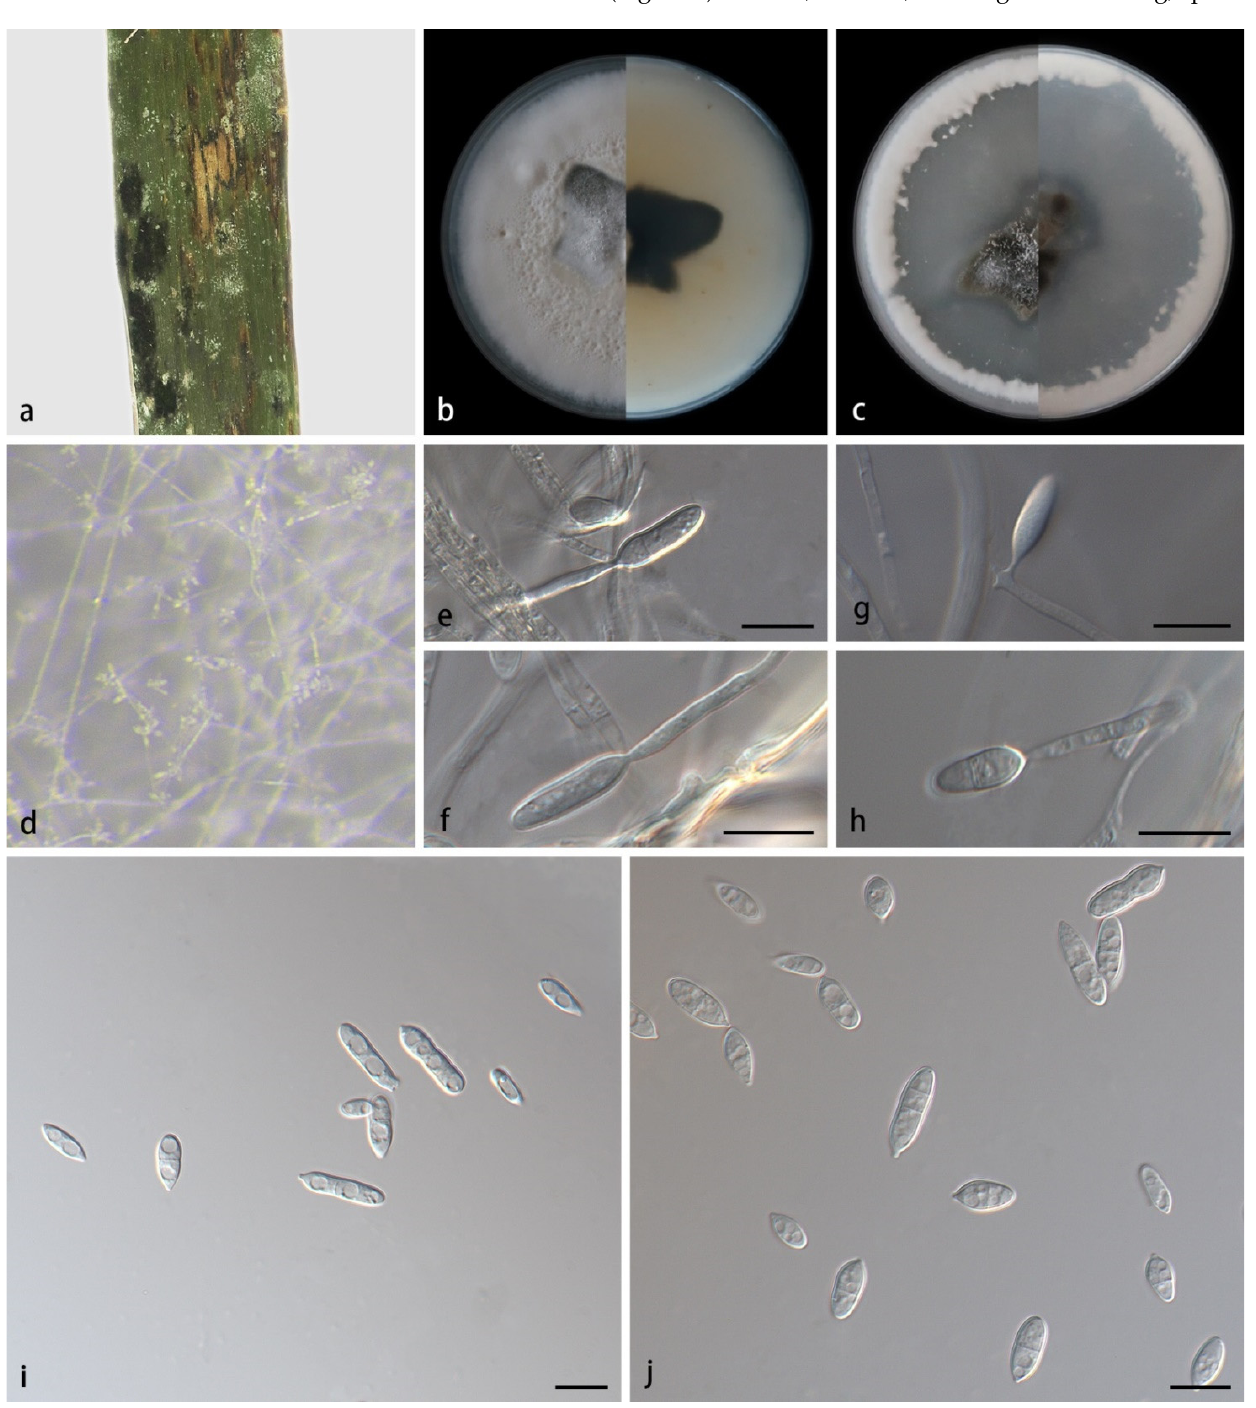
Figure 2. Microdochium miscanthi (holotype HMAS352151, ex-holotype SAUCC211092). ( a ) Leaves of host plant; ( b ) inverse and reverse sides of colony after 15 days on PDA; ( c ) inverse and reverse sides of colony after 15 days on OA; ( d ) a colony overview; ( e – h ) conidiophores and conidiogenous cells; ( i , j ) conidia. Scale bars: ( e – j ) 10 μ m.